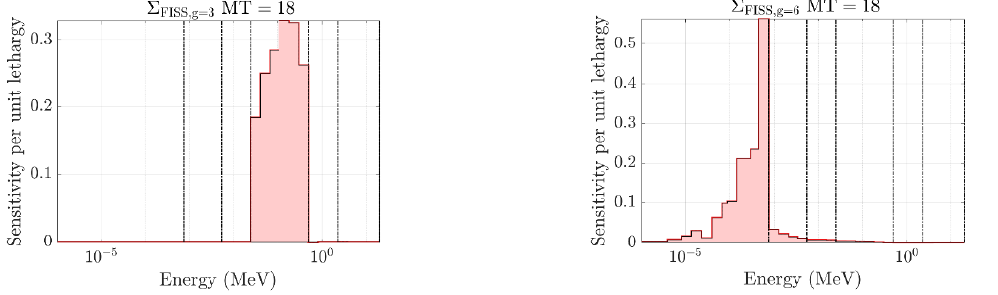
Figure 3: ECCO 33-groups sensitivity coefficients evaluated with GPT technique.